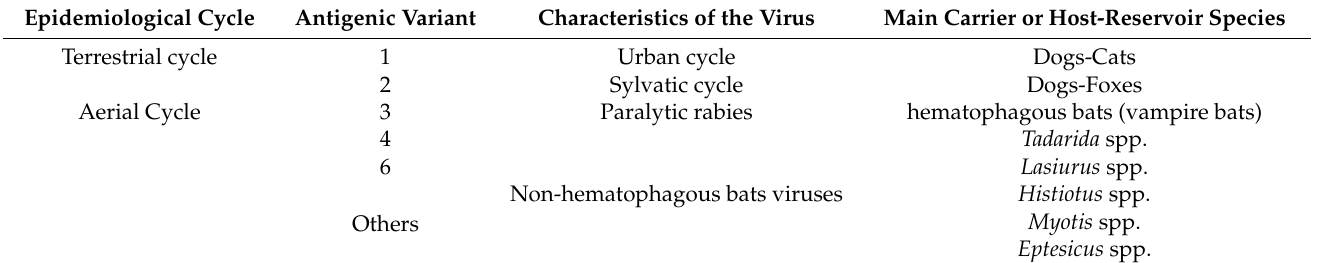
Table 1. Antigenic variants of rabies virus identified in South American countries. Epidemiological Cycle Antigenic Variant Characteristics of the Virus Main Carrier or Host-Reservoir Species Terrestrial cycle 1 Urban cycle Dogs-Cats 2 Sylvatic cycle Dogs-Foxes Aerial Cycle 3 Paralytic rabies hematophagous bats (vampire bats) Tadarida spp. 4 6 Lasiurus spp. Non-hematophagous bats viruses Histiotus spp. Myotis spp. Others Eptesicus